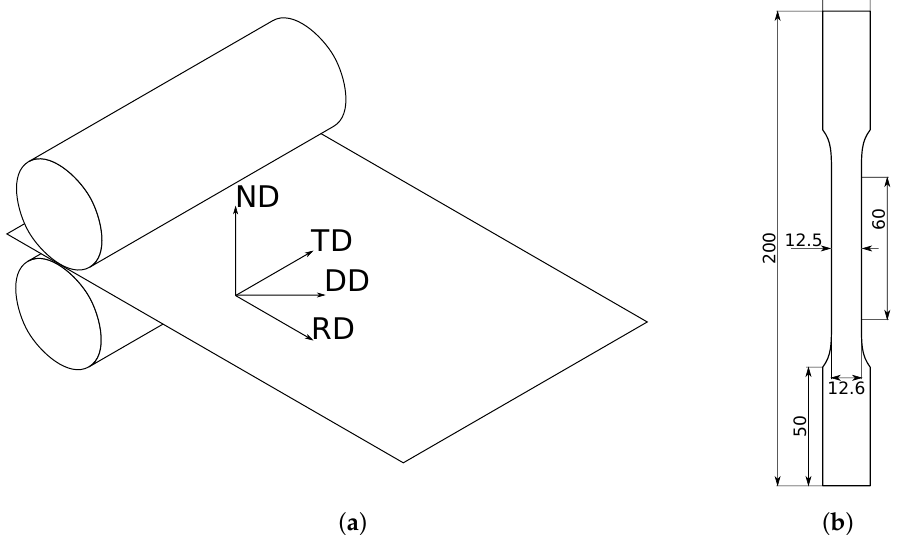
Figure 1. ( a ) Common directions of laminated sheets and ( b ) dimensions of the tensile specimen (in